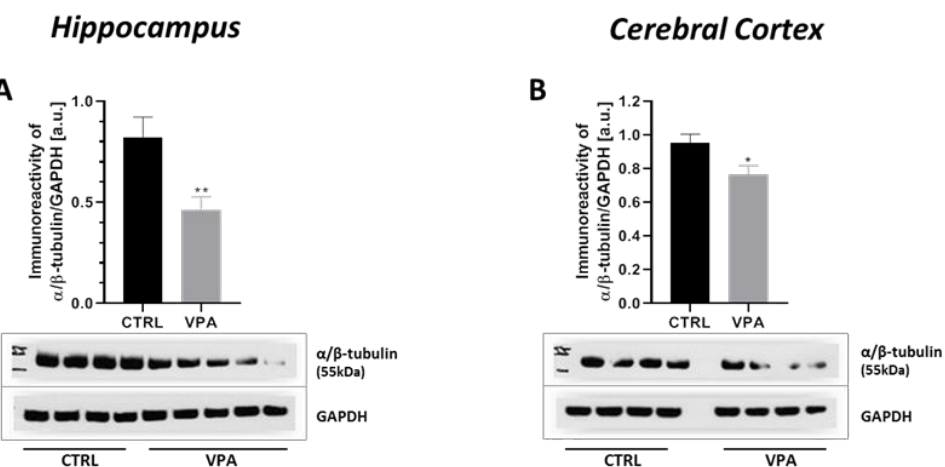
Figure 1. The effect of prenatal exposure to valproic acid (VPA) on the protein level of α / β -tubulin in the rat brain. Immunoreactivity of α / β -tubulin in control and VPA-exposed rats was monitored using Western blot analysis. Densitometric analysis and representative pictures of α / β -tubulin in the hippocampus ( A ) and cerebral cortex ( B ) were shown. Results were normalized to glyceraldehyde 3-phosphate dehydrogenase (GAPDH) levels. Data represent the mean values ± SEM from n = (11–14) independent experiments in the hippocampus: ( A ) n = 11 (CTRL), n = 14 (VPA); and n = (11) in the cerebral cortex: ( B ) n = 11 (CTRL), n = 11 (VPA). * p < 0.5, ** p < 0.01, vs. control.